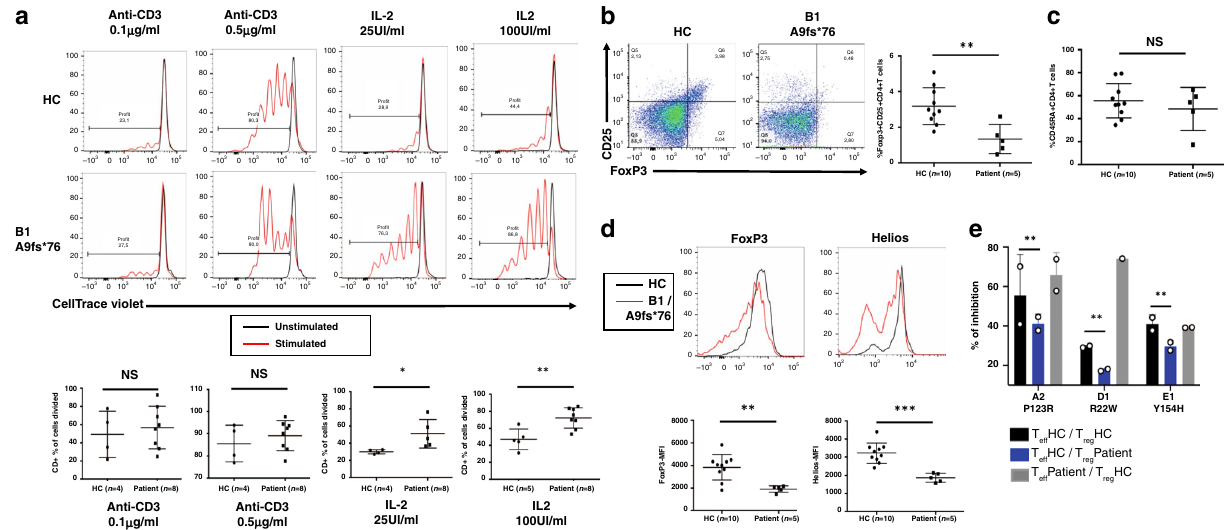
Fig. 4 Impact of SOCS1 mutations on T cell proliferation and on regulatory T cells. a Proliferation of T-cell blasts from healthy controls (HC) and patients. Day-10 T-cell blasts were stimulated or not with IL-2 (100 IU/ml), or anti-CD3-coated beads for 4 days. Proliferation was determined from the level of dilution of the CellTrace Violet dye. The panel shows proliferation of all T cells (CD3 + ). Top: representative histograms showing cell divisions of T-cell blasts (red peak) from an HC and from patient B1. Peak in black: unstimulated cells. The data are quoted as the percentage of cells having undergone at least one division. Bottom: the percentage of dividing cells from HCs and patients (data pooled from n = 4 independent experiments including a total of four HC, fi ve patients with IL-2 25UI/ml and eight patients with anti-CD3 or IL-2 100UI/ml). Two-tailed p values were determined in an unpaired t test (IL-2 25UI/ml p = 0.0433, IL2 100UI/ml p = 0.0038, NS, not signi fi cant). b Left: a representative fl ow cytometry analysis of FoxP3 and CD25 markers in CD4 + T cells from an HC and from patient B1. Right: FoxP3 + CD25 + CD4 + T cells (as a percentage of total CD4 + T cells) in the peripheral blood of HCs ( n = 10) and patients ( n = 5). c Naïve CD45RA + CD4 + T cells (as a percentage of total CD4 + T cells) in the peripheral blood of HCs ( n = 10) and patients ( n = 5). d Top: representative histograms of FoxP3 and Helios expression in CD4 + CD25 + CD127 low T cells from an HC (black) and patient B1 (red). Bottom: mean fl uorescence intensity (MFI) of the respective T reg cell markers in HCs ( n = 10) and patients ( n = 5). b – d Two-tailed p values were determined in a Mann – Whitney test (Panel B p = 0.0047; Panel D FoxP3 p = 0.008, Helios p = 0.0007, NS, not signi fi cant). a – d Data indicate mean with SD, and each dot corresponds to an individual. e Suppressive activity of regulatory T cells. VioBlue-labeled T eff cells were cultured in the absence or presence of T reg cells from HCs and patients (A2, D1, and E1). Proliferation was determined from the level of dilution of the VioBlue dye. Graphs indicate percentages of suppression from patients. Data are from three independent experiments in duplicate with a healthy control and indicated patient tested in pairs. Data indicate mean with SD of technical replicates due to the lack of cells for more experiments. Two-tailed p value was determined in a paired t-test between patients and controls ( p = 0.0055). a – e * P ≤ 0.05; ** P ≤ 0.01, *** P ≤